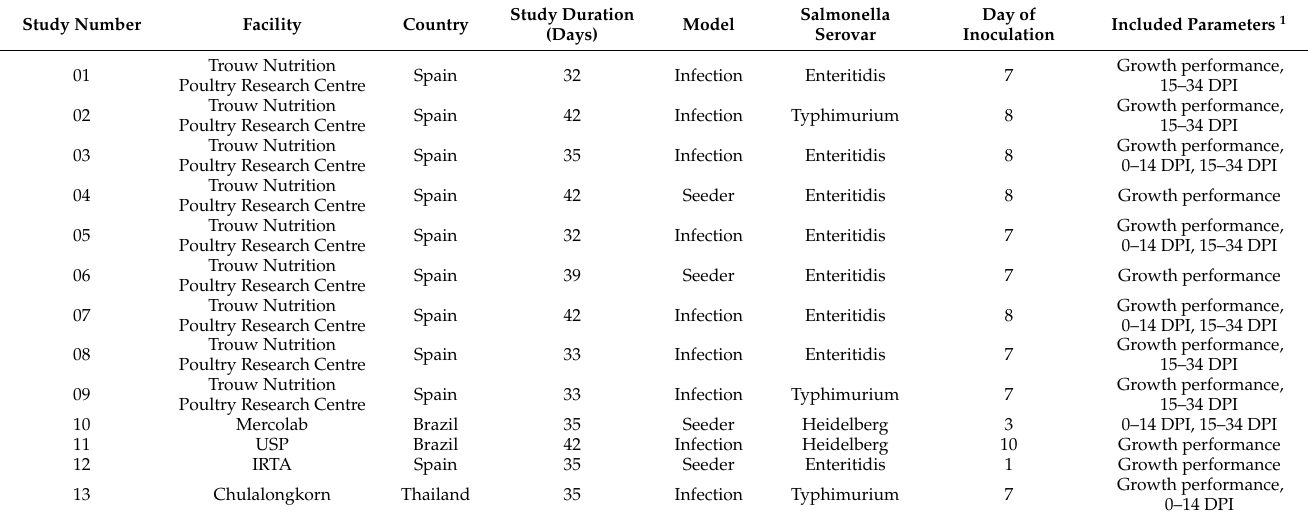
Table 1. Studies included in the